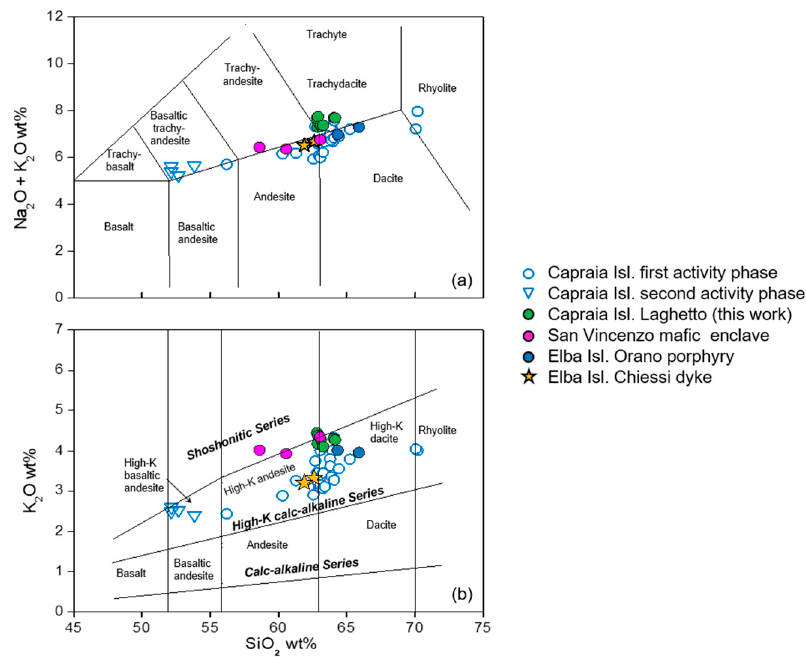
Figure 4. ( a ) TAS and ( b ) K 2 O vs. SiO 2 classification diagrams for Capraia rocks. Open circles (first activity phase) and triangles (second activity phase): data from the literature [9,28]; full green circles: this work. Some Elba dykes [15,35] and mafic enclaves from San Vincenzo [16,34] are also plotted for comparison. Data are plotted on water-free basis.